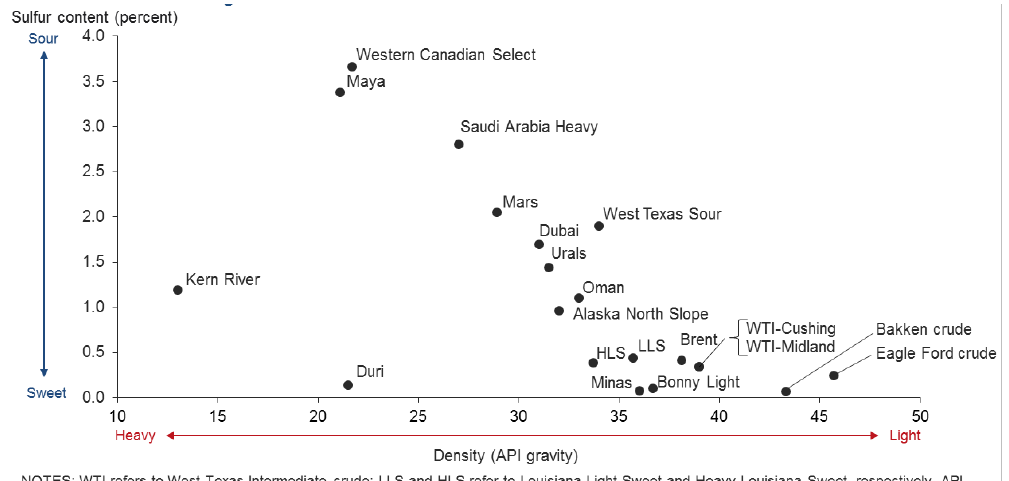
Figure 1. Crude oil is not a homogenous resource. Source: Bloomberg and Platts [7]. Reprinted with permission from Federal Reserve Bank of Dallas [6].